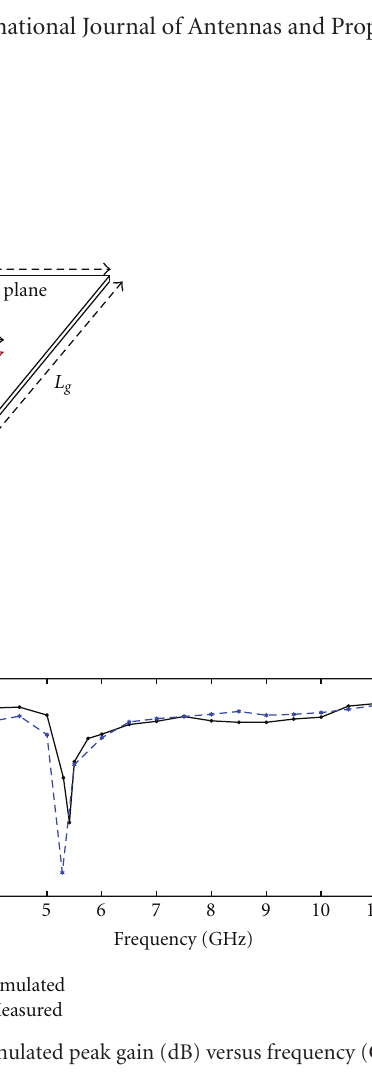
Figure 2: The built PIFA with SMA connector.